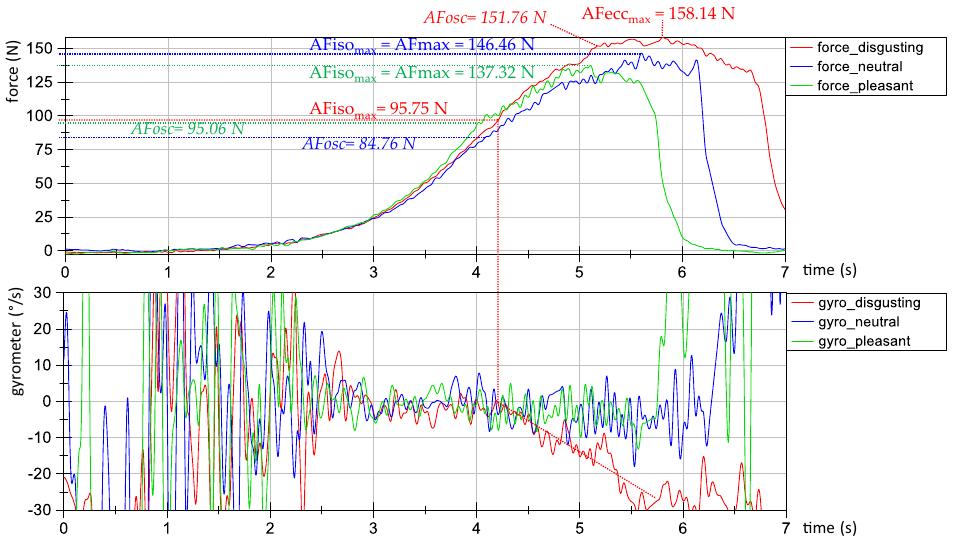
Figure 4. Exemplary signals. Displayed are the force (N) (above) and gyrometer signals (°/s) (below) during manual muscle test (MMT) of tester 1 testing the same female participant (age: 44 years, height: 173 cm, body mass: 77 kg) during disgusting (red), neutral (blue) and pleasant (green) odours. Marked are the parameters AFmax, AFecc max , AFiso max and AFosc (according to Figure 12 in 39